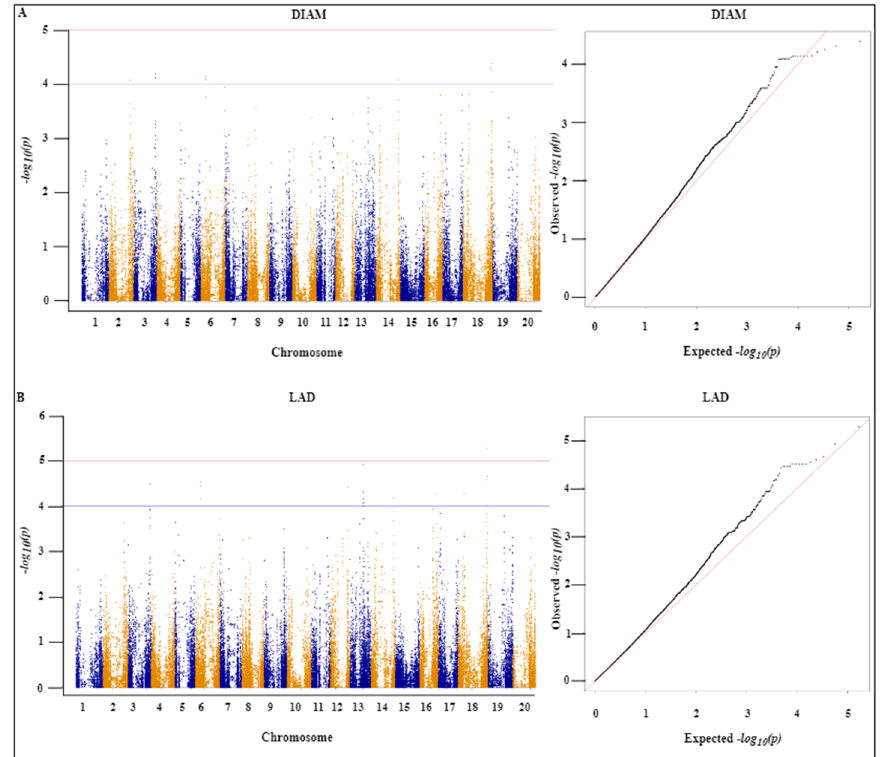
Figure 2. Manhattan and quantile-quantile (QQ) plots of the 357 soybean landraces using the MLM model. ( A ) Root average diameter (DIAM) and ( B ) link average diameter (LAD). The X -axis repre- sents the chromosome number, and the Y-axis represents the − log 10 p ) value. The threshold of 4.0 (Bonferroni correction) was adopted with the blue line in the Manhattan plots. The Manhattan and QQ plots are based on analyses of the association between 84,210 chromosomal SNPs and DIAM and LAD traits.